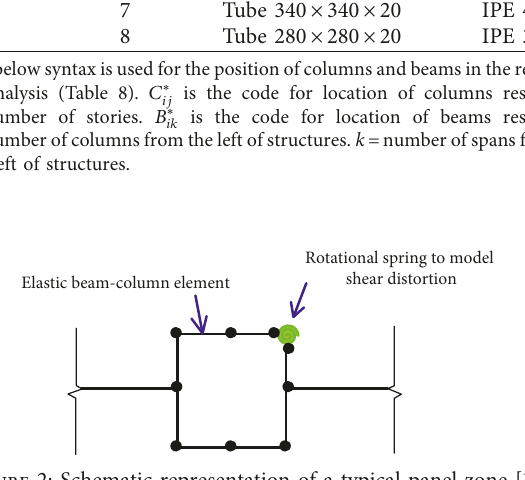
Figure 2: Schematic representation of a typical panel zone